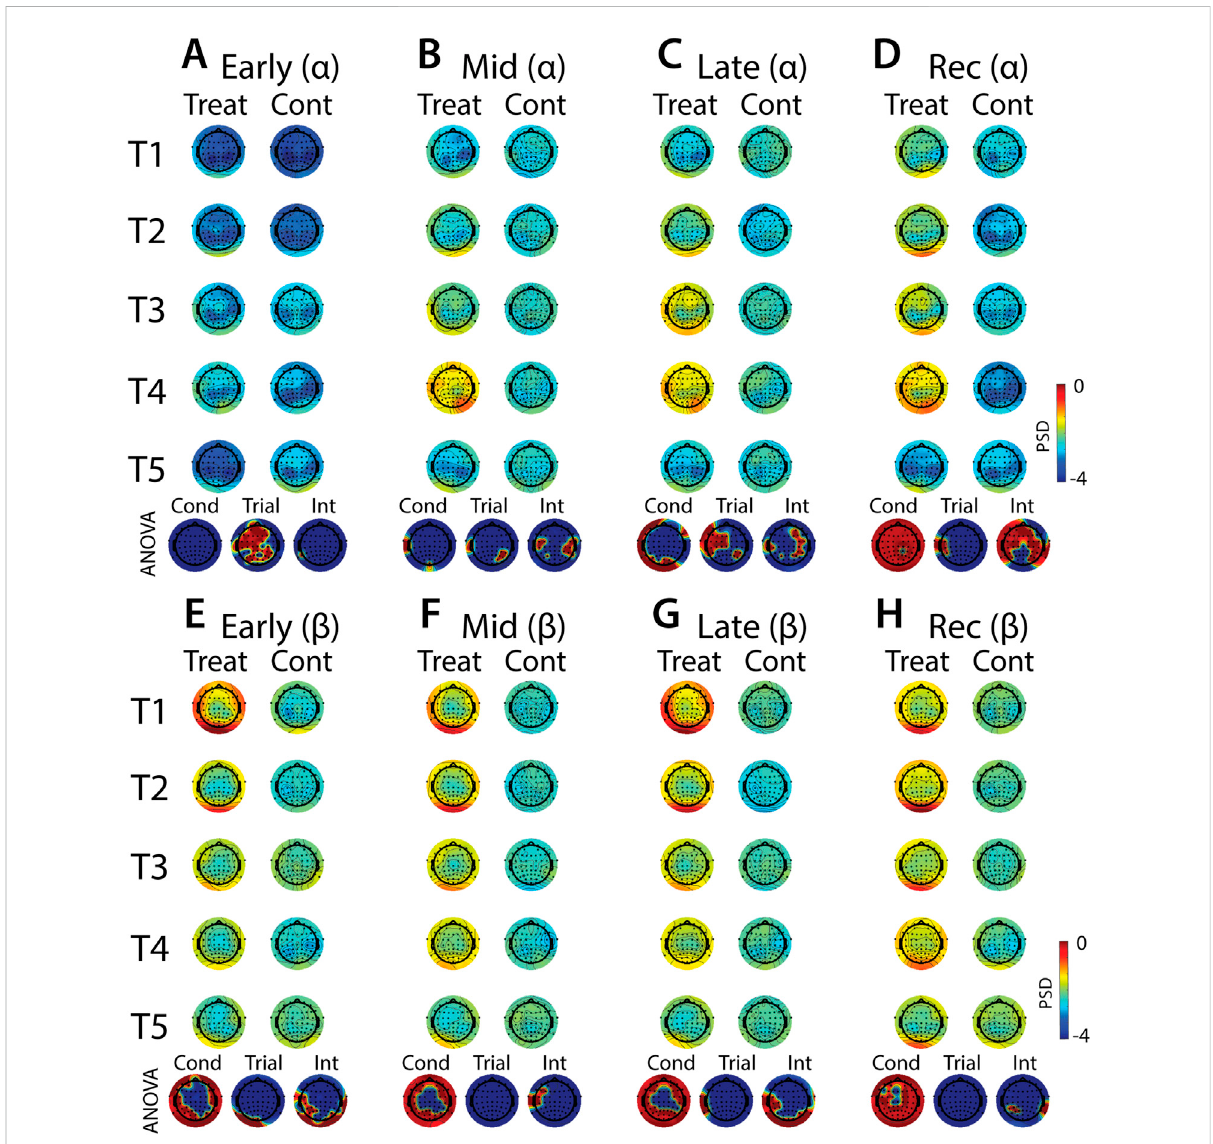
FIGURE 11 Effects of treatment and repeated trial exposure on stress-evoked oscillatory neural activity in alpha and beta frequency bands. Topographic plotsineachpaneldepictevokedstresseffectsonoscillatoryneuralactivityinthealpha (A – D) andbeta (E – H) frequencybands.Topographicplotsin panels A – D and E – H respectively represent brain activity averaged across the early (65 – 94 s), mid (95 – 124 s), late (125 – 154 s) and recovery (155 – 190 s)periodsoftheimmersionperiod.Eachpanelcontainsseparatecolumnsofplotsforthetreatmentandcontrolconditions,witheach repetition trial (T1-T5) represented by each row. Condition (treatment, control) by trial (T1-T5) ANOVA results at each electrode are plotted at the base of each panel, with condition, trial and interaction effects depicted in separate topographic plots. Scalp regions overlaid in red indicate signi fi cant effects ( p null <